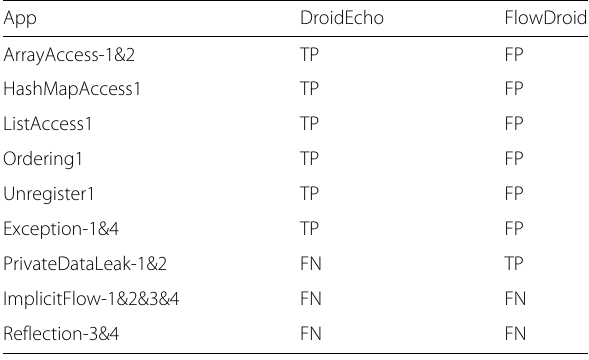
Table 3 Comparison with FlowDroid